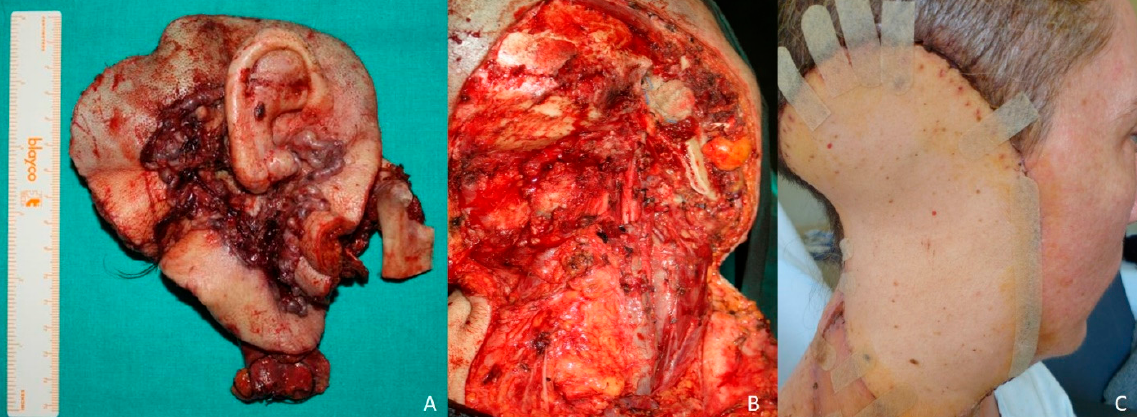
Figure 5. Latissimus dorsi flap. ( A ) Resection with clear margins including the ascending ramus of the mandible and the condyle. ( B ) Defect created after resection of the carcinoma including the ear, facial nerve, parotid gland, ascending ramus of the mandible and condyle. ( C ) Reconstruction with latissimus dorsi (LD) flap.